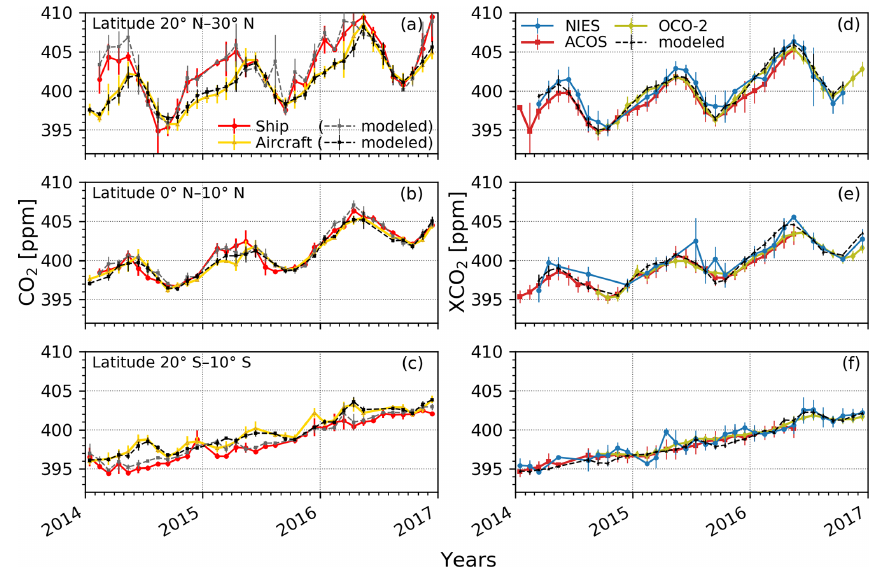
Figure 3. Temporal variation of the monthly average CO 2 mixing ratio obtained by ship (red) and aircraft (yellow) (a, b, c) , and the column- averaged mixing ratios (XCO 2 ) from the NIES (blue), ACOS (red), and OCO-2 (olive) (d, e, f) in three representative latitude ranges for the northern midlatitudes (a, d) , the Equator region (b, e) , and southern latitudes (c, f) . Results of the ACTM are shown as dashed lines. Error bars represent the standard deviation of the monthly averages. Table 1. Root-mean-square error (RMSE), and average difference and standard deviation between the retrievals from aircraft, ship, satellite and the corresponding results from the ACTM at different latitude ranges between 2014 and 2017. RMSE Latitude Aircraft Ship NIES ACOS OCO-2 20–30 ◦ N 0.54 1.26 0.93